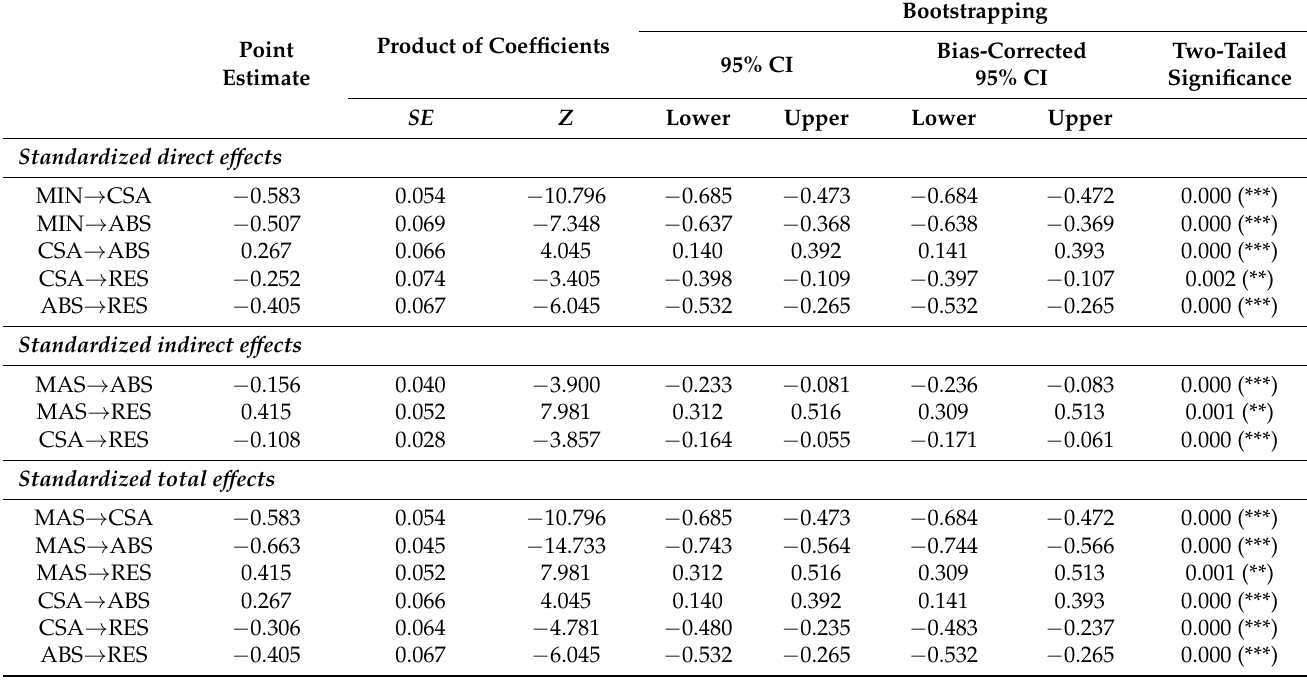
Table 4. Standardized direct, indirect, and total effects .